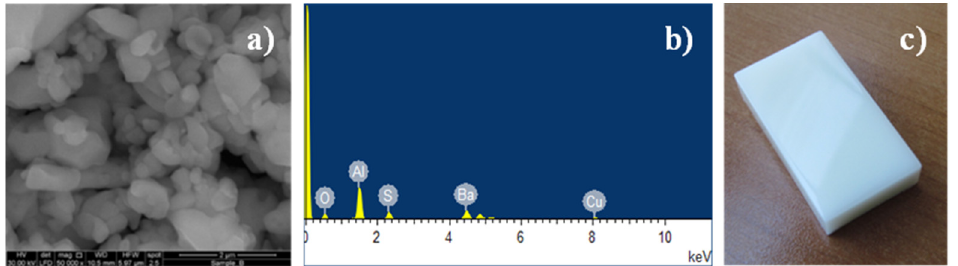
Figure 6. SEM micrograph of the BaSO 4 powder ( a ), related EDS spectrum ( b ), and BaSO 4 /epoxy sample image ( c ).